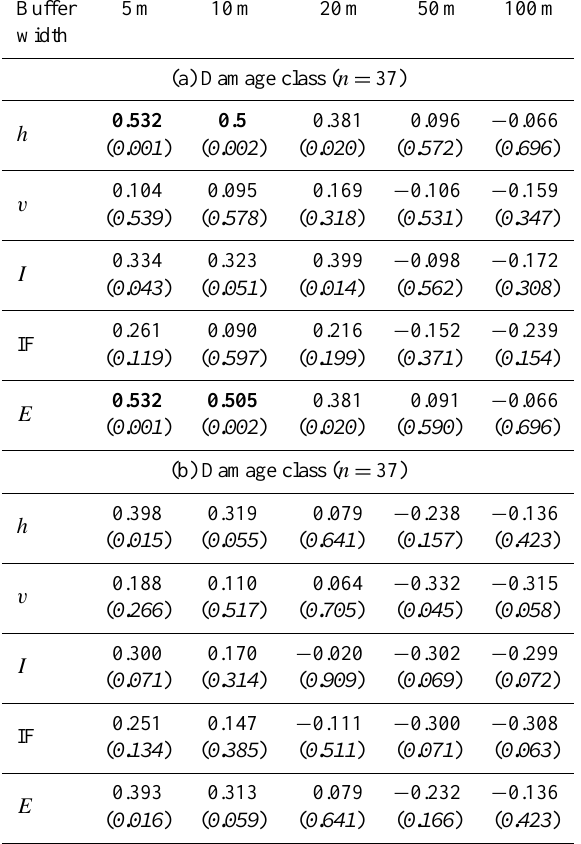
Table 2. Spearman’s rank correlation coefficients between the de- pendent variable “damage class” and each independent variable “impact parameter” based on the mean values (a) and maximum values (b) for varying buffer widths. The coefficients meeting the threshold level of meaningfulness, which has been set to 0.5 within this study, are highlighted in bold type. Additionally, the corre- sponding p values (two-tailed, 5% error) are provided in brackets and in italics.